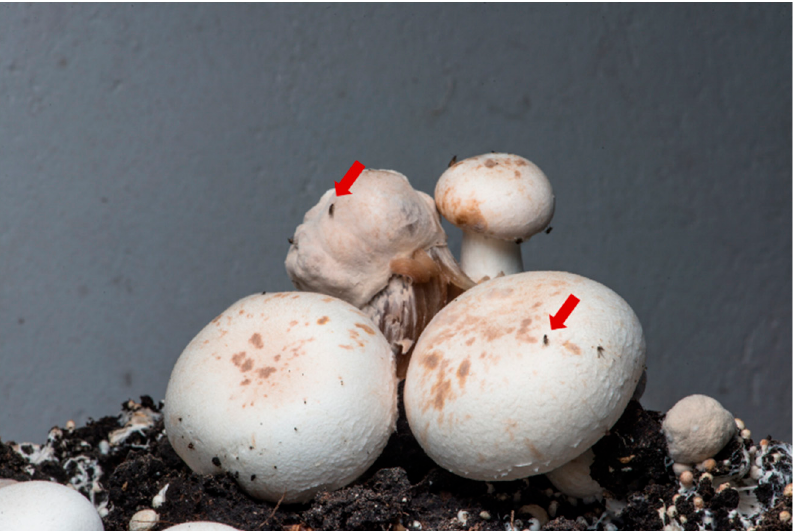
Figure 1. Phorid flies on button mushroom infected by dry bubble ( Lecanicillium fungicola ). CIES